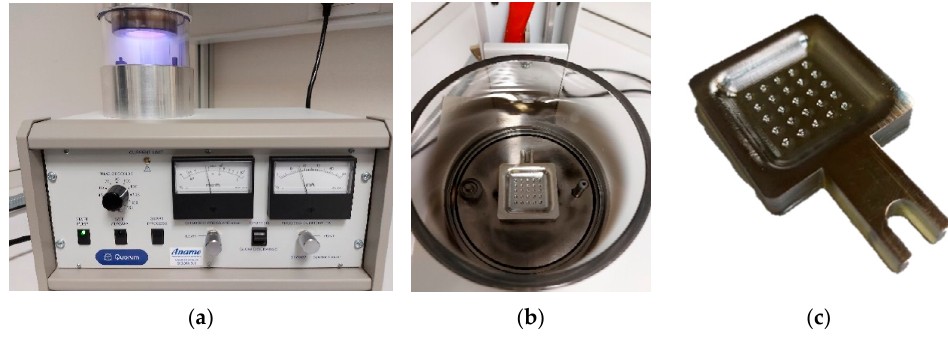
Figure 3. ( a ) Sputtering machine ( b ) Discharge chamber ( c ) Process result.